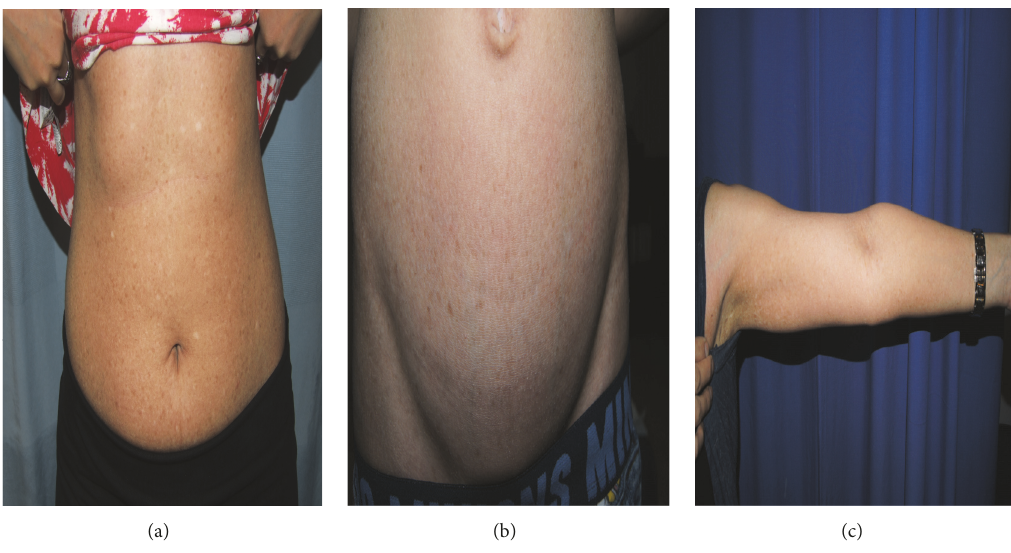
Figure 2: Clinical findings of dyschromatosis universalis hereditaria in a mother and her son: multiple hyper- and hypopigmented macules of varying sizes can be noted over the trunk and upper limb ((a)–(c)).